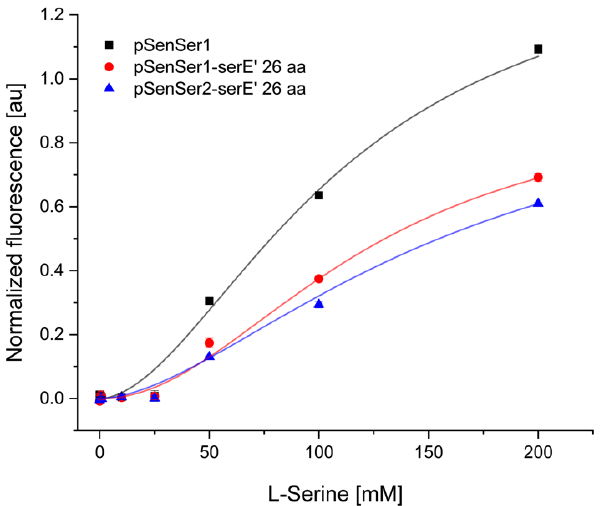
Figure 3. Dose–response curve of C. glutamicum ATCC 13032 ∆ serA with different L -serine-responsive biosensor plasmids in cultivations with different concentrations of extracellularly added L -serine. The biosensor fluorescence output at each effector concentration was determined after subtraction of the cell autofluorescence and by normalization to the cell density. The curves were fitted to the Hill equation. Means and error bars were determined from the analysis of three independent cultures.